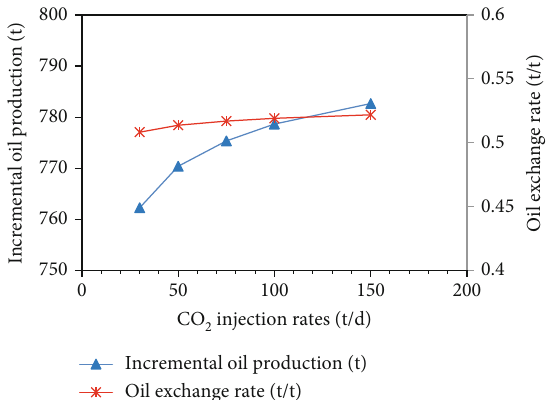
Figure 16: Incremental oil production and oil exchange rate through CO hu ff -n-pu ff under di ff erent CO 2